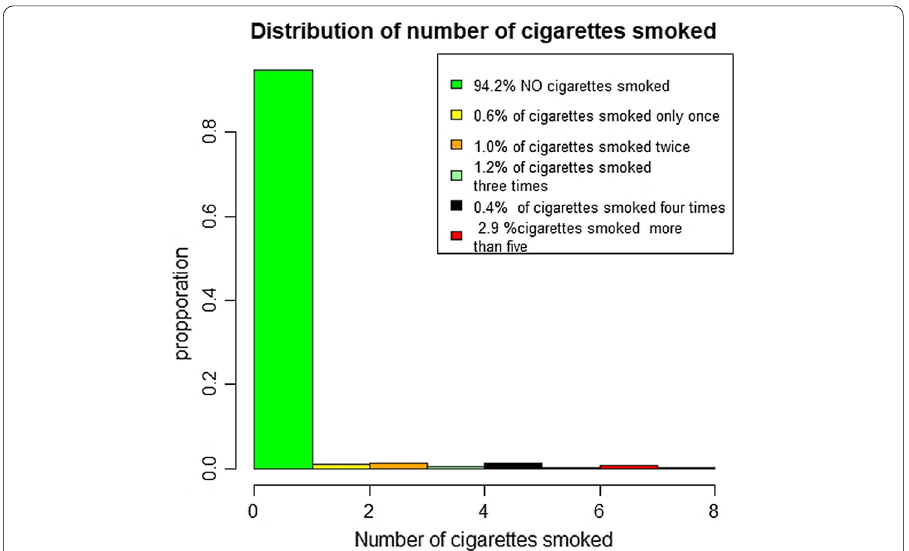
Fig. 1 Histogram of the number of cigarettes smoked per day in